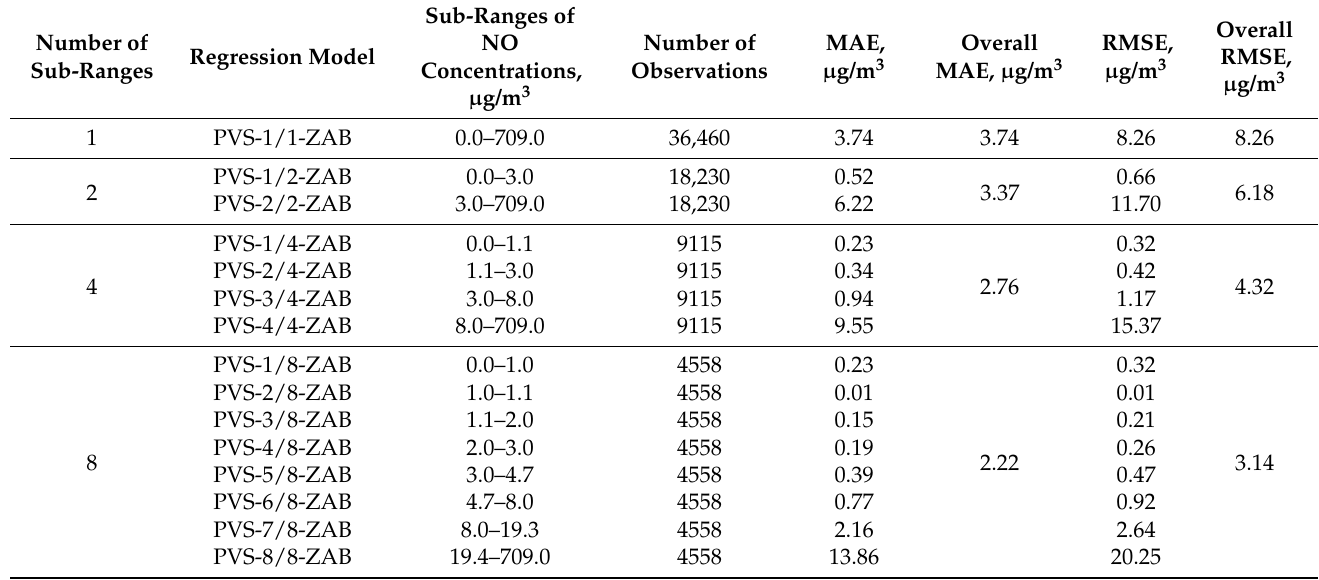
Table 7. Values of approximation errors of NO concentrations in PVS models, Zabrze 2011–2016.